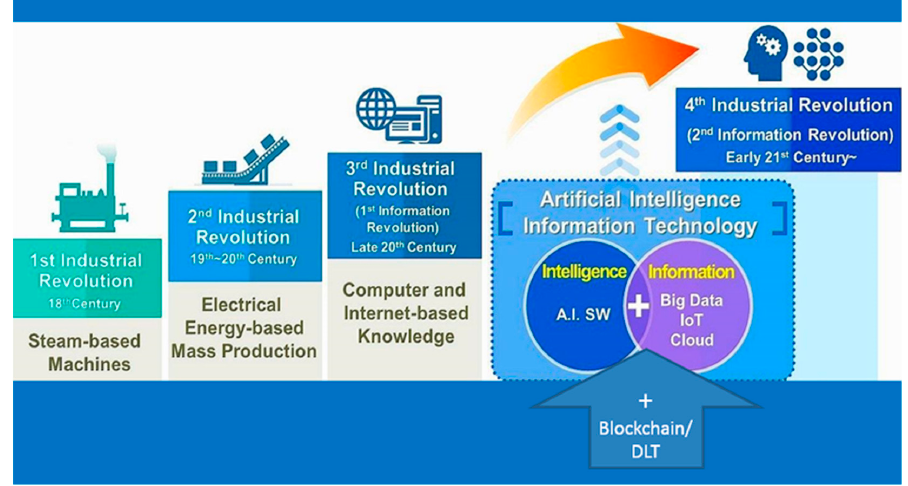
Figure 3. Fourth industrial revolution. Source: Kagermann et al. (2013).